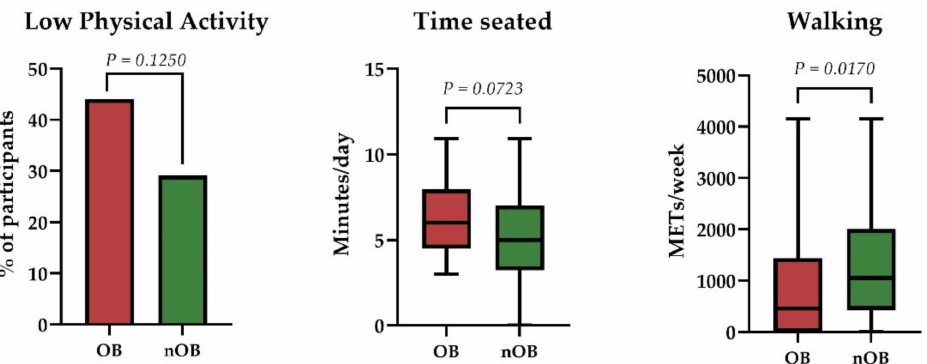
Figure 3. Comparison between patients with (OB) or without (nOB) obesity. Proportion of participants with a low level of physical activity, as assessed by IPAQ-SF (left), time spent seated (center) and amount of energy expended